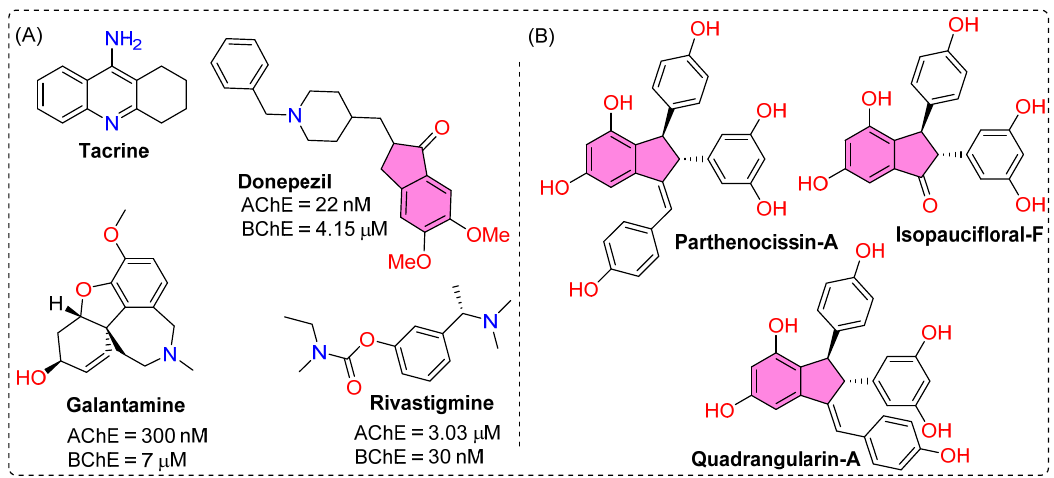
Figure 1. ( A ) Chemical structures of clinically approved Acetylcholinesterase inhibitors (AChEIs) in AD. ( B ) Indene scaffold (highlighted in pink color) containing medicinally active compounds.